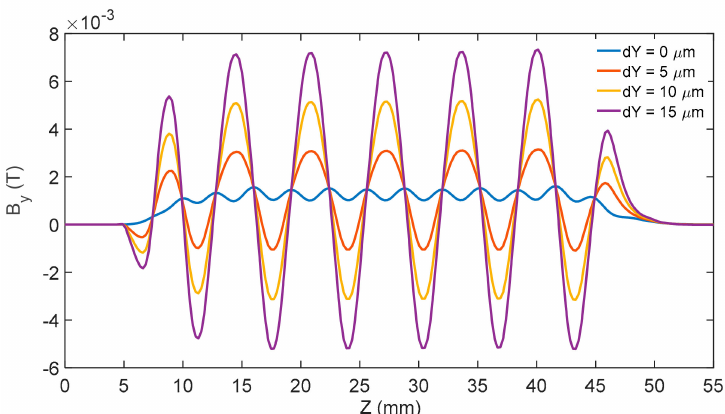
Figure 7. Sensitivity analysis of the side magnetic field B y ,side